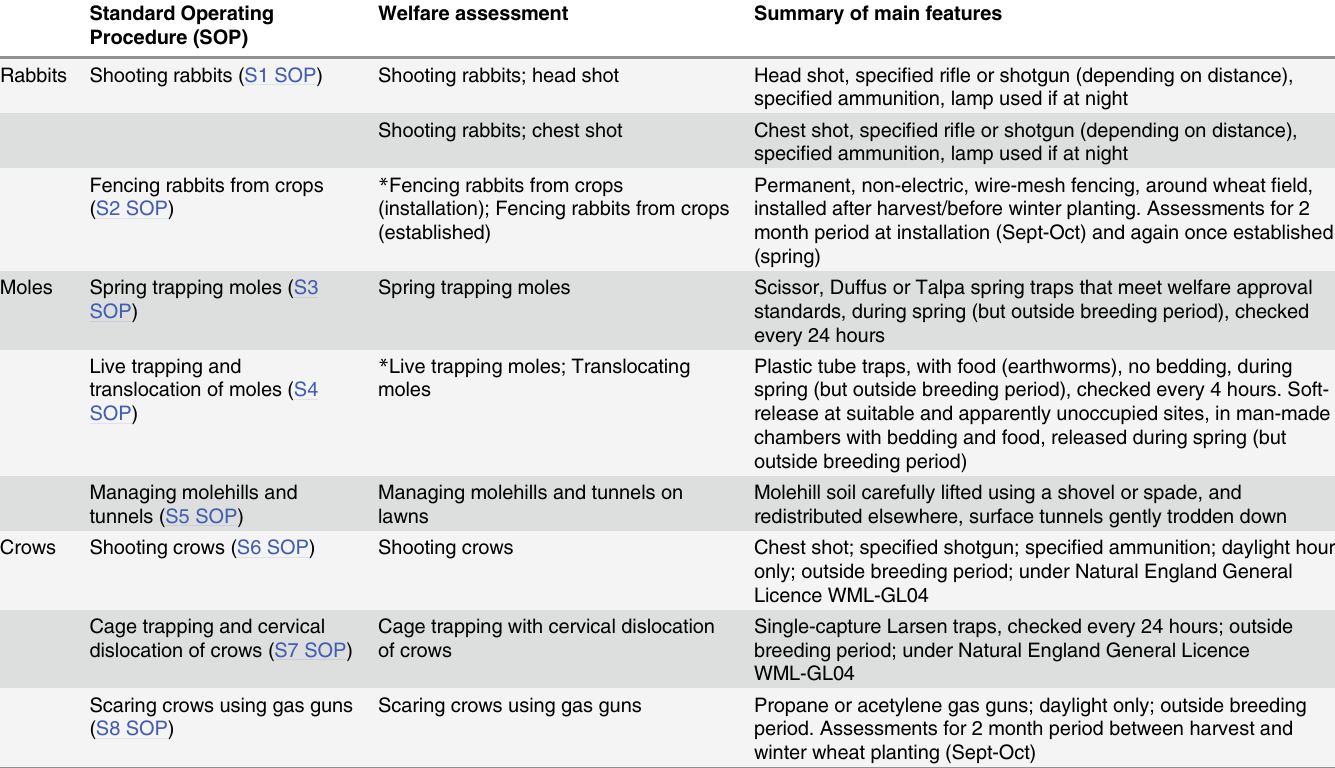
Table 1. Details of the eight standard operating procedures created and the nine associated welfare assessments (both head and chest shots for rabbits are covered by a single SOP). Standard Operating Procedure